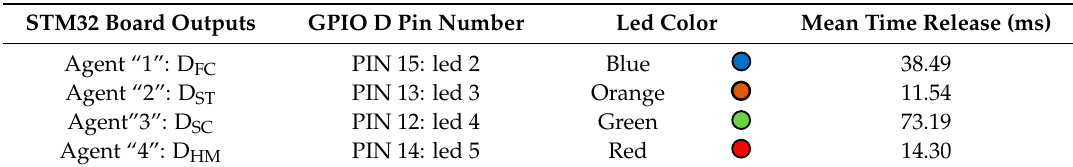
Table 6. STM32 output system parameters.